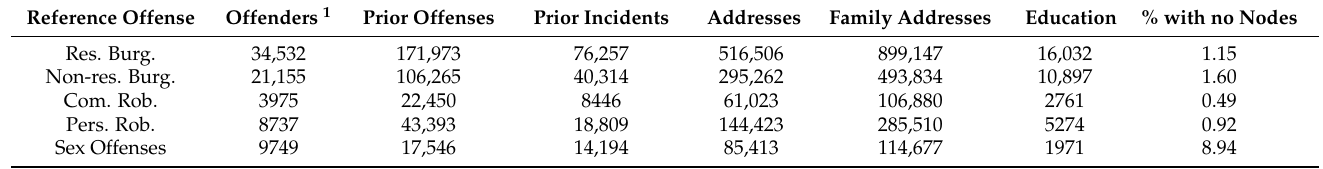
Table 1. Sample size in each dataset relative to each reference offense category.